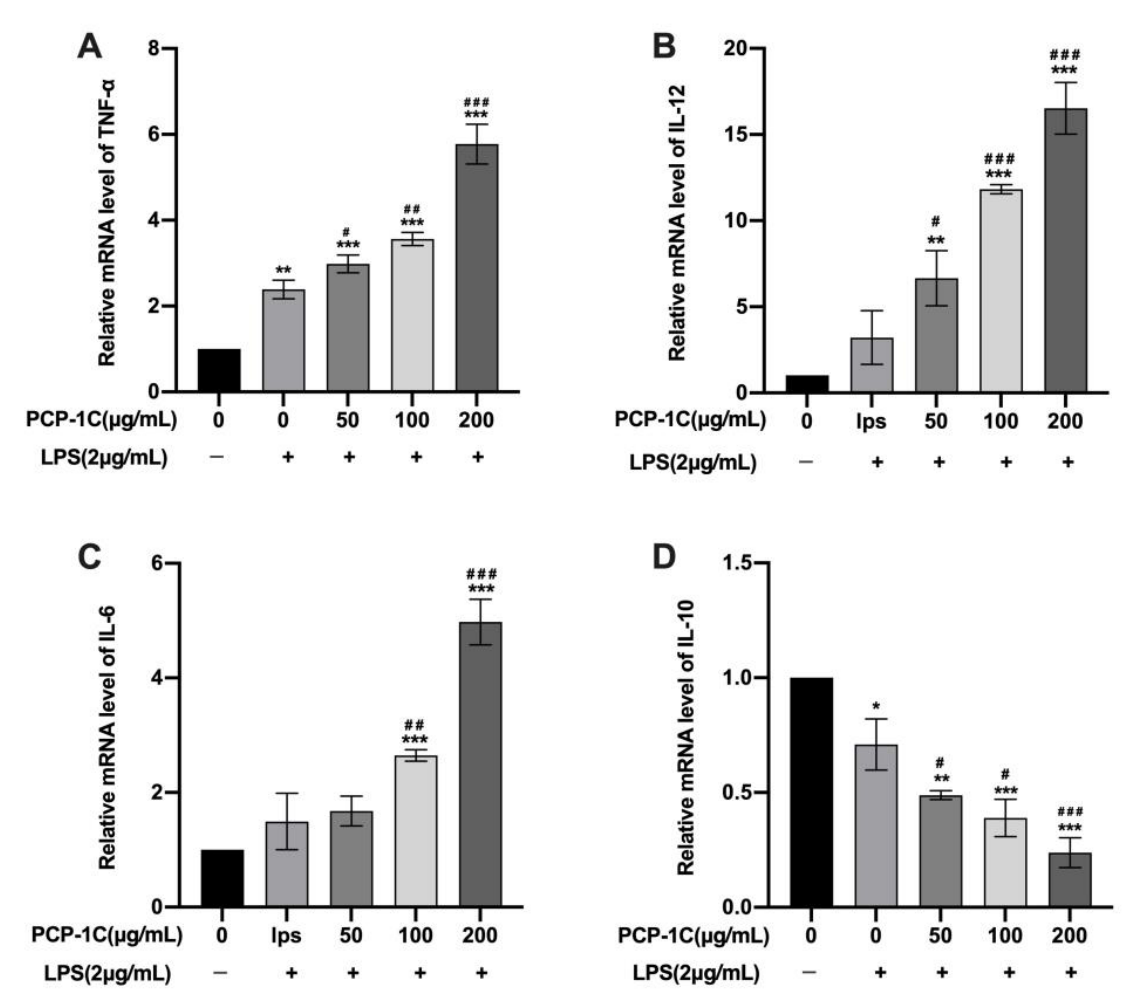
Figure 6. Quantitative real-time PCR (qRT-PCR) detects the mRNAs of the cytokines in macrophages. Macrophages were incubated for 24 h in the presence of 50 µ g/mL, 100 µ g/mL, and 200 µ g/mL PCP-1C and/or 2 µ g/mL LPS. mRNA expressions of cytokine levels of TNF- α ( A ), IL-12 ( B ), IL-6 ( C ), and IL-10 ( D ) were detected by qRT-PCR. * p < 0.05, ** p < 0.01, *** p < 0.001 vs. Control, # p < 0.05, ## p < 0.01, ### p < 0.001 vs. LPS; “ + ” indicates the cells were treated with LPS while “−” indicates they were treated without LPS.